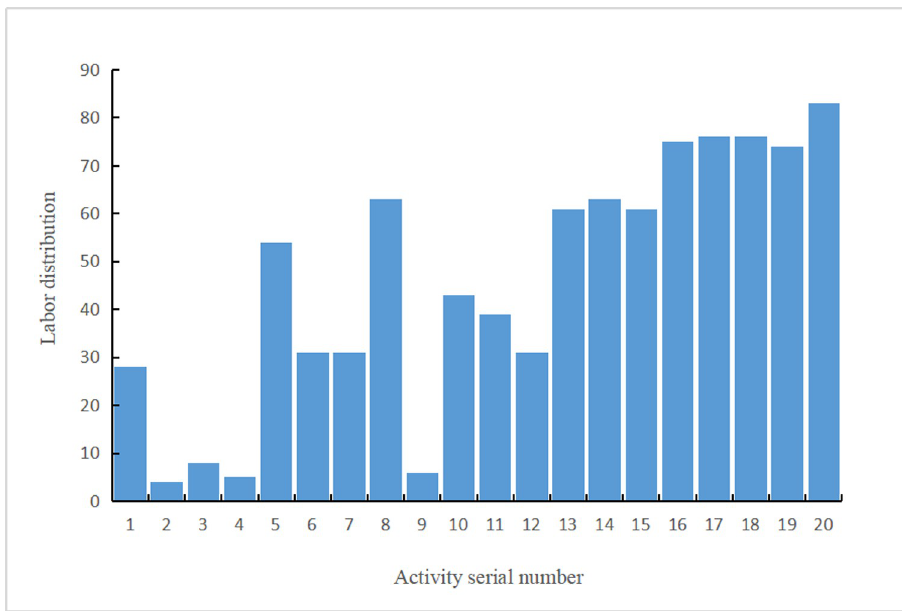
Fig 6. Labor force distribution of each